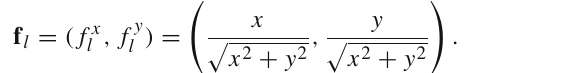
Fig. 2 Image of a geometrically thin infinite accretion disk around a Schwarzschild black hole by polarized light coupled with Weyl tensor for the observer with r o = 100 M and θ o = 70 ◦ . The upper row is for